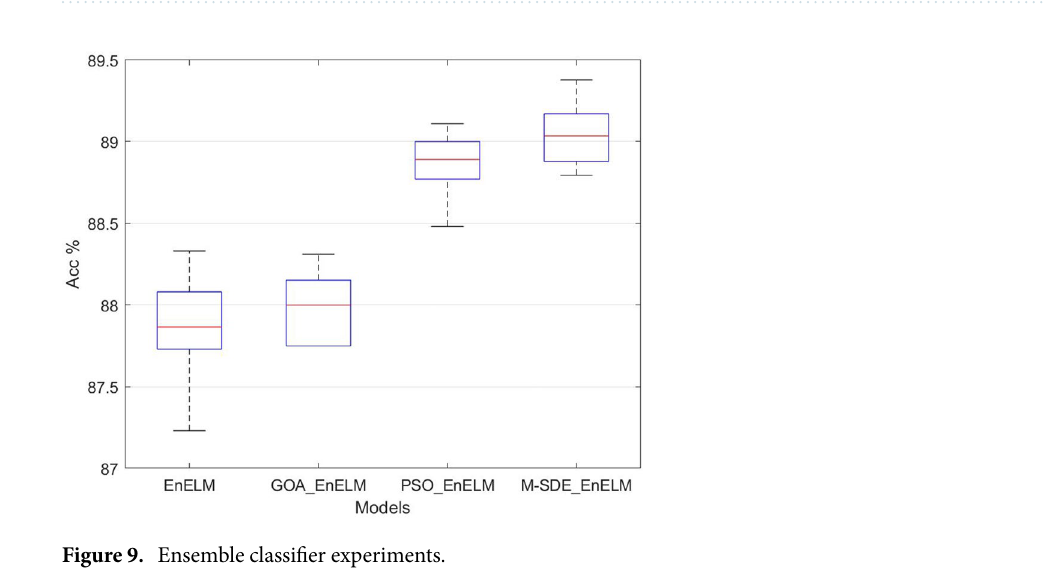
Table 6. Performance of ensemble classifier.